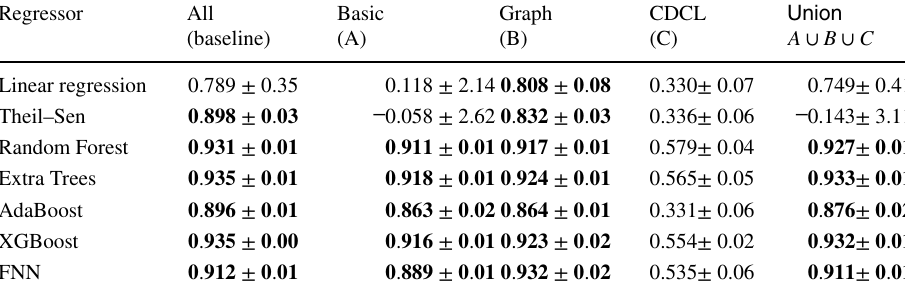
Table 4 Average of coefficient R 2 for different of determination regression methods (with optimized hyperparameter), for different features